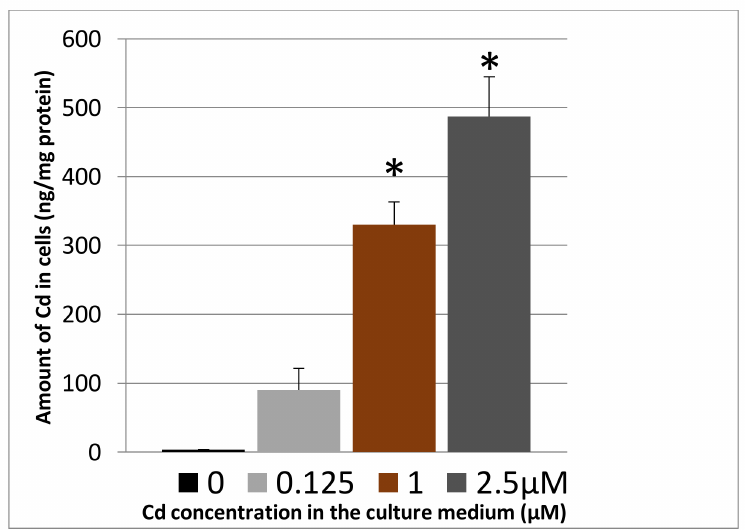
Figure 2. Cadmium uptake by INS-1 cells. The amount of cadmium in washed cells was measured by inductively-coupled plasma-mass spectrometry (ICP-MS) after 72 h of cadmium exposure and normalized to the protein concentration. * ANOVA test, p < 0.001 vs. 0 µ M Cd 2+ ( n = 3).